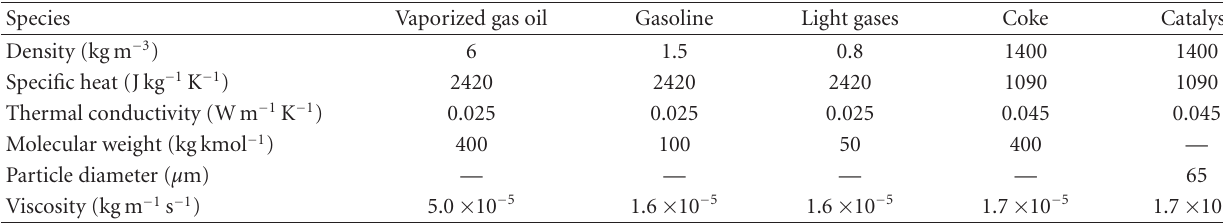
Table 7: Physical properties of reactive species and catalyst.